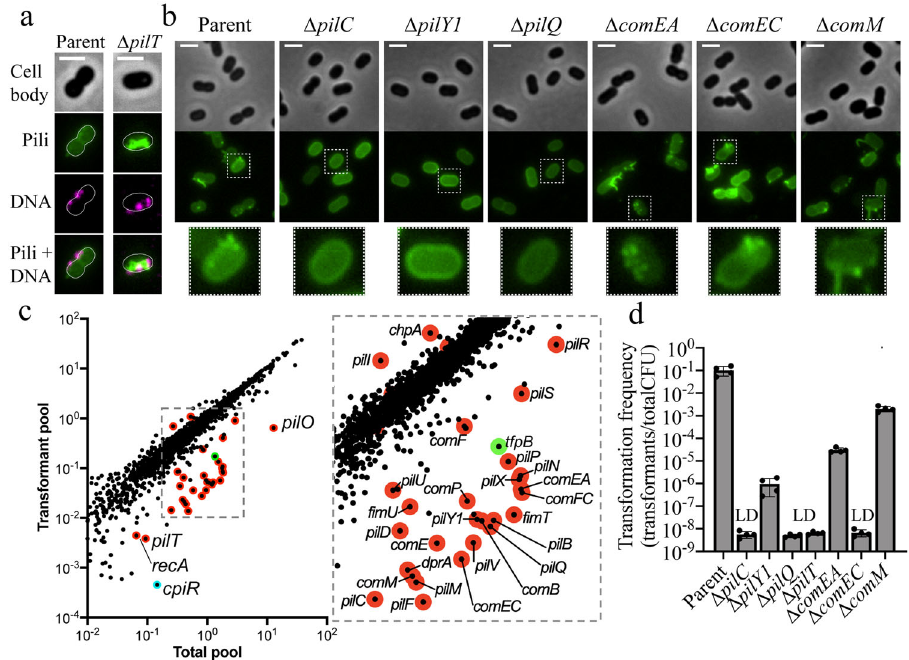
Fig. 1 Tn-seq reveals factors important for natural transformation and T4P synthesis. a Representative images of cells with AF488-mal-labeled pili incubated with fl uorescently labeled DNA. b Representative images of pilT -intact strains from natural transformation assays shown in d labeled with AF488-mal. Zoomed-in images of representative single cells from each strain are outlined in dashed boxes and shown below. Scale bars, 2 µ m. c Visual representation of Tn-seq screen showing the relative abundance of each gene in the “ total pool ” of transposon mutants compared to the “ transformant pool ” recovered after natural transformation. Known T4P structural/regulatory genes are outlined in red. tfpB is outlined in green, and cpiR is outlined in cyan. d Natural transformation assays of indicated strains. Each data point represents a biological replicate ( n = 4) and bar graphs indicate the mean ± SD. LD limit of detection. Source data are provided as a Source Data fi